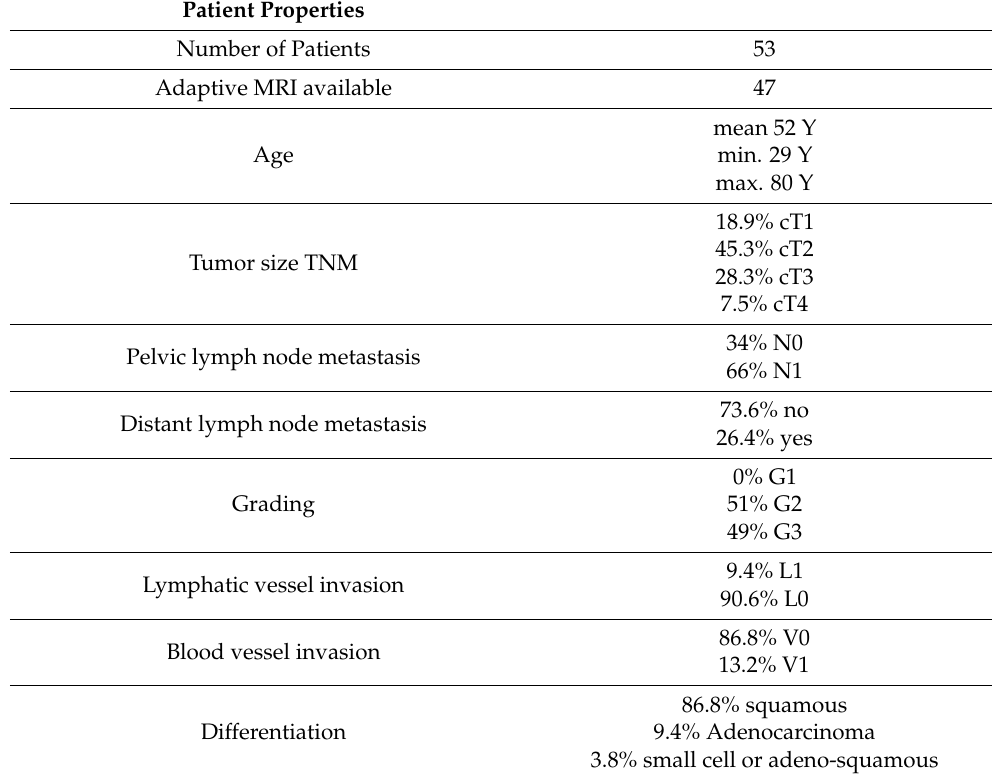
Table 1. Patient